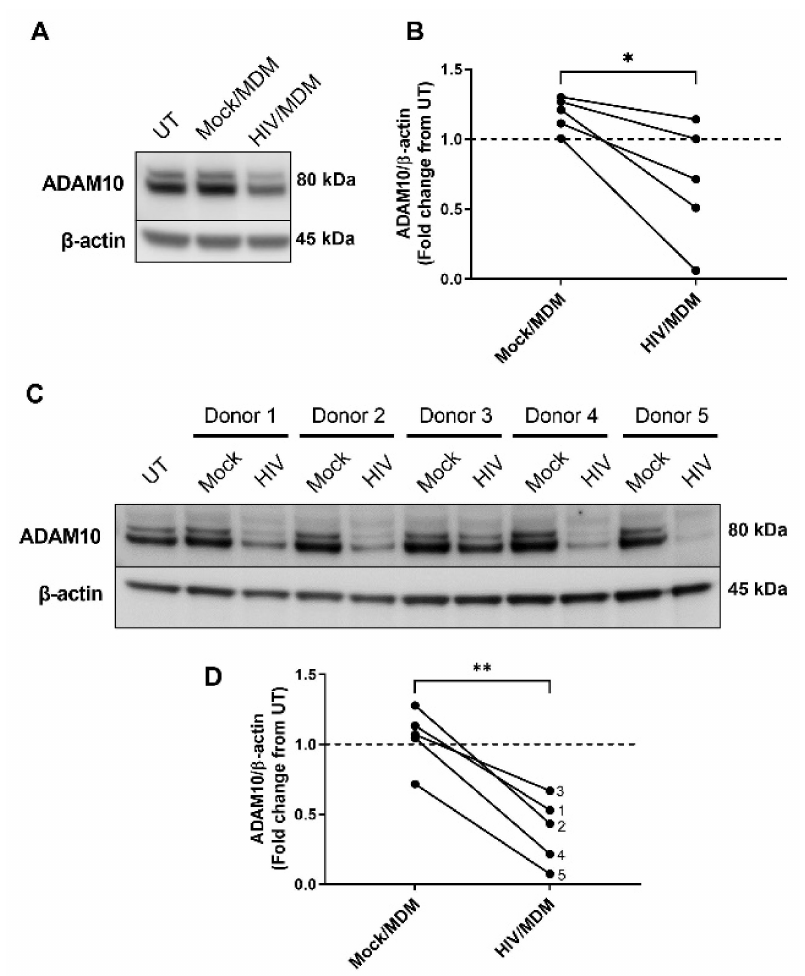
Figure 2. HIV/MDM supernatant treatment alters protein levels of APP secretase ADAM10. Protein lysates were collected from purified primary rat neuronal cultures after 16 h treatment with Mock or HIV/MDM supernatants. Representative blots are shown ( A ). Treatment with HIV/MDMs decreased levels of ADAM10 when compared to Mock/MDMs across five different isolates of primary rat cultures to account for variability across independent culture preparations ( B ). Statistical significance was calculated using paired t test. * Represents p < 0.05 compared to Mock/MDMs ( n = 5). Protein lysates were collected from rat neuronal cultures after 16 h treatment with five different sets of Mock and HIV/MDM supernatants to account for variability across individual macrophage donors. Representative blots are shown ( C ). Treatment with HIV/MDMs significantly decreased ADAM10 when compared to Mock/MDMs. Each number represents the macrophage donor pair ( D ). Statistical significance was calculated using paired t test. ** Represents p < 0.01 ( n = 5). Dotted line represents untreated